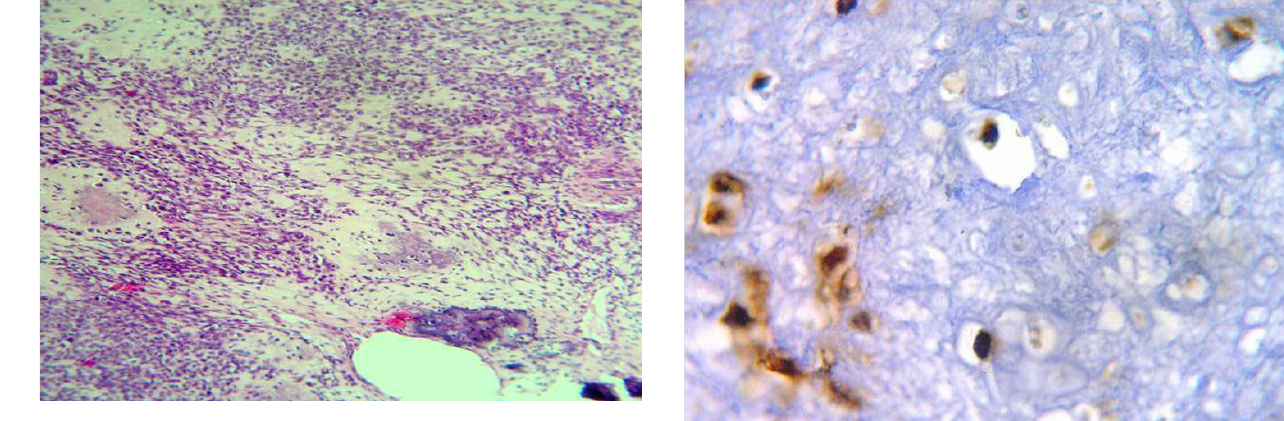
Figure 3 Foci of malignant cartilage with anaplastic hyperchromatic pleomorphic cells dispersed in myxoid stroma (H &E